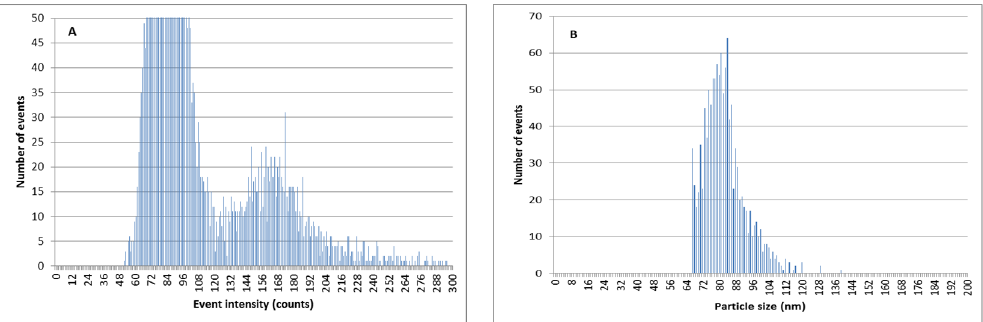
Figure 7. Remaining silver fraction (Ag + or AgNPs) in column experiments using River Water 2 as matrix. ( A ) New resin. ( B ) Reconditioned resin. Silver concentration: 100 μg·kg − 1 ; Flow rate: 1.3 mL·min − 1 ; Amount of resin: 0.5 g.